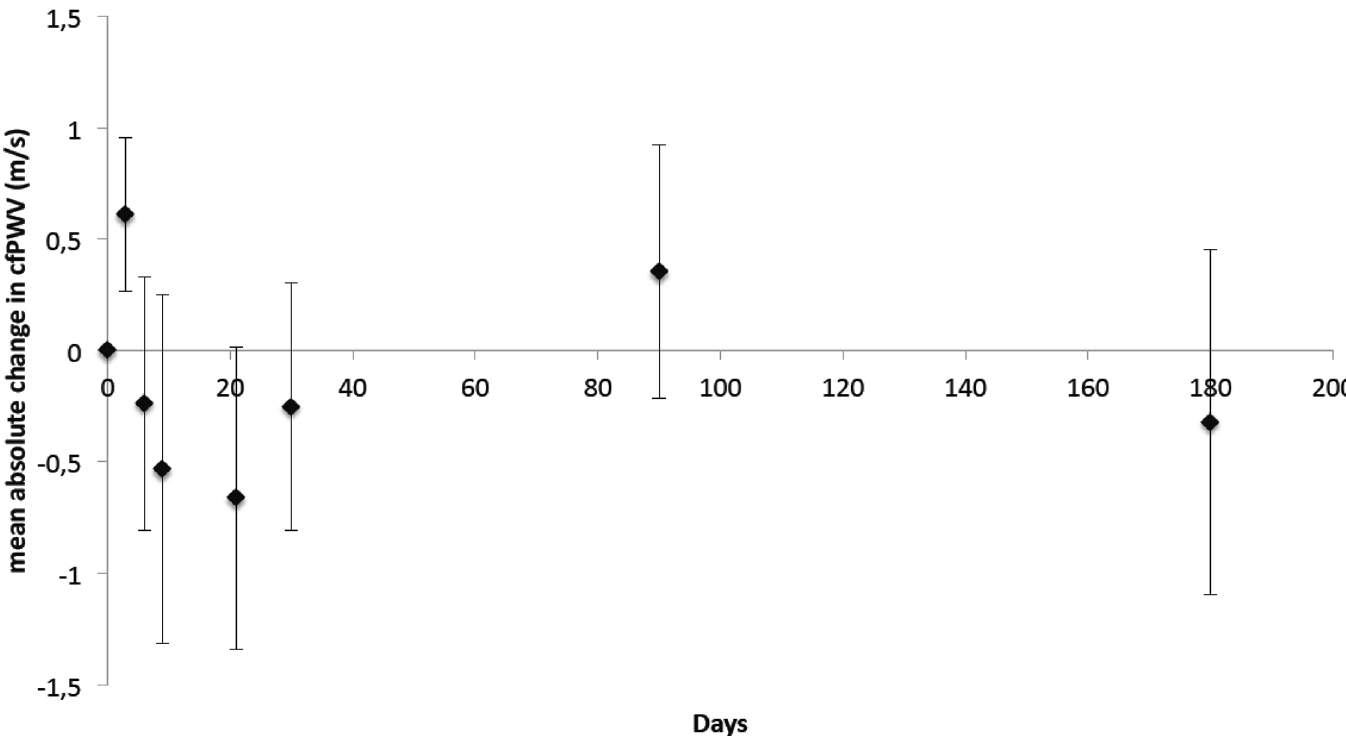
Fig 2. Absolute course of change in cf-PWV (m/s) ( ± standard error of the mean) over time. Mean absolute change in cf-PWV (m/s) over time relative to initial cf-PWV measurement taken within 48 ± 24 hours of hospital admission as assessed using applanation tonometry. Cf-PWV increased acutely at day 3 after initial assessment, and declined thereafter, remaining lower than at initial assessment until day 30. At day 90, there was a slight increase in cf-PWV compared to day 30, but at day 180, cf-PWV returned to the levels measured at day 30.